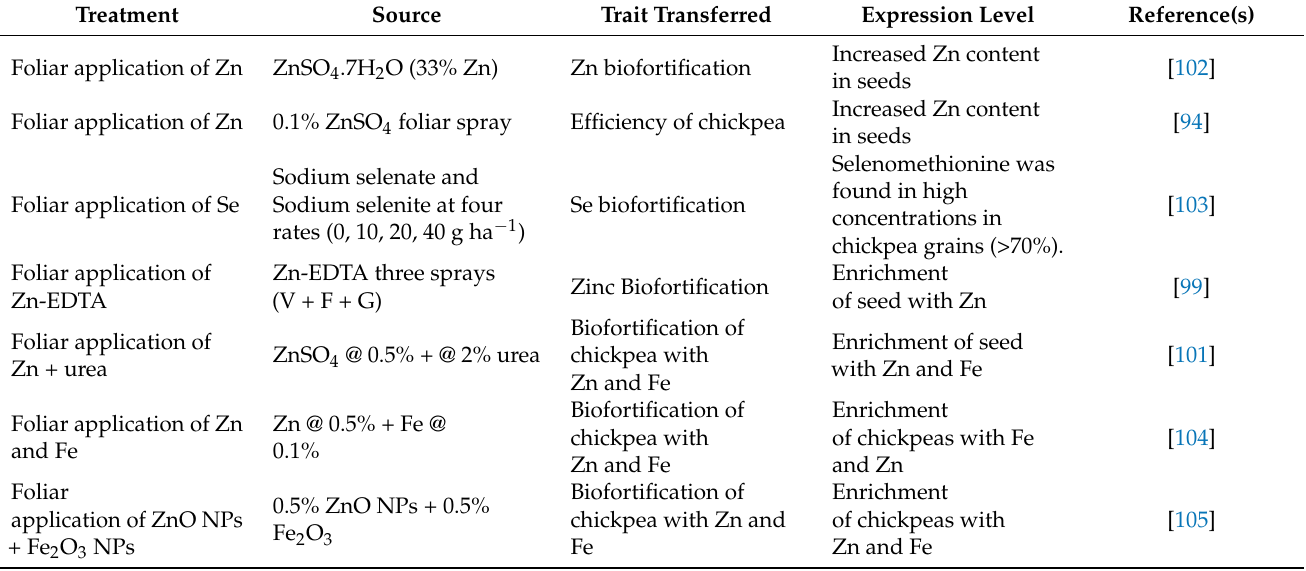
Table 4. Biofortification of chickpea ( Cicer arietinum L.) through foliar method.